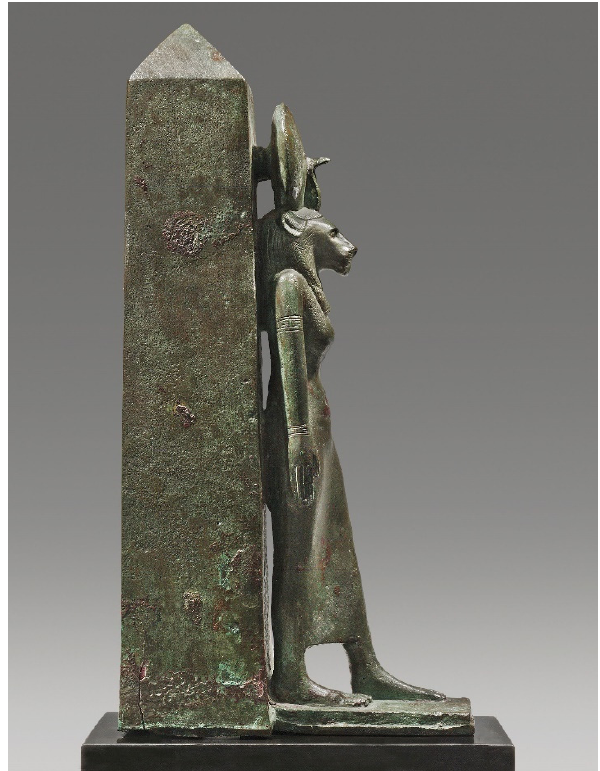
Figure 8. A bronze reliquary for an ichneumon dedicated to the Egyptian goddess Wadjet, right side. (Private collection, courtesy of the owner).